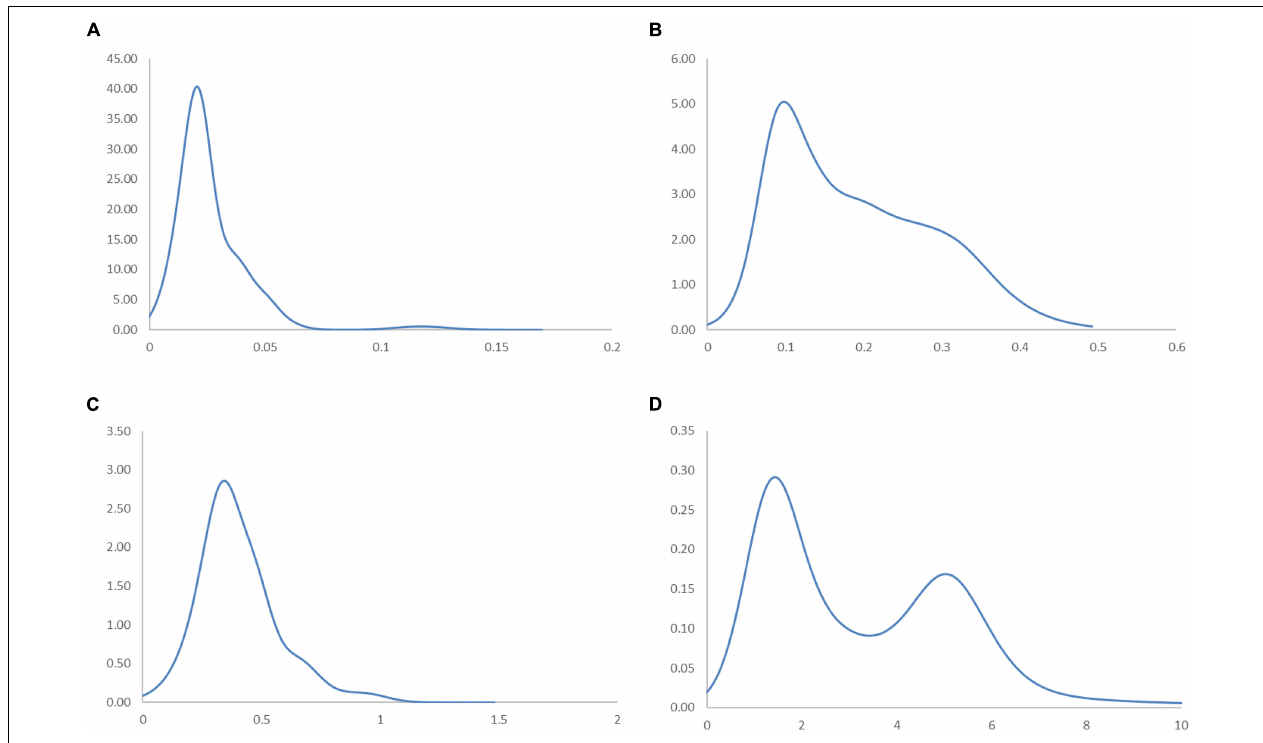
FIGURE 11 | Ergodic distributions for the RSVAPC of countries for different income groups of countries with annual transitions. Source: Authors’ calculation. N.B. The vertical axis indicates the density of probability and the horizontal axis indicates RSVAPC values. (A) Low-income countries; (B) Lower-middle income countries; (C) Upper-middle income countries; (D) High-income